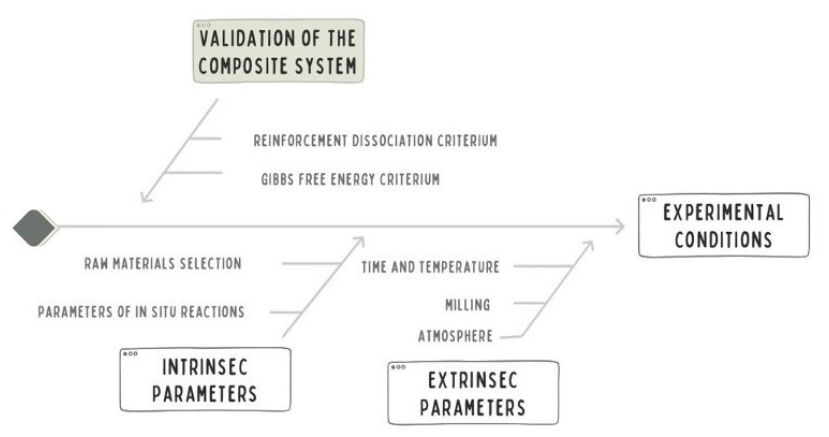
Figure 19. Flowchart summarizing parameters discussed in this review as a means of designing experimental conditions for in situ composite manufacture by powder metallurgy.